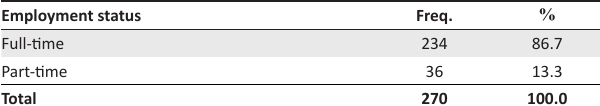
TABLE 1g: Background of respondents.